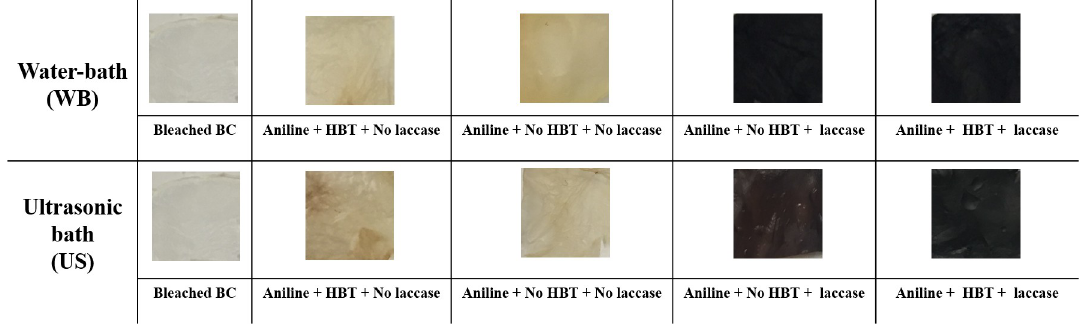
Fig 9. Photographs of BC samples after in situ aniline polymerization under different